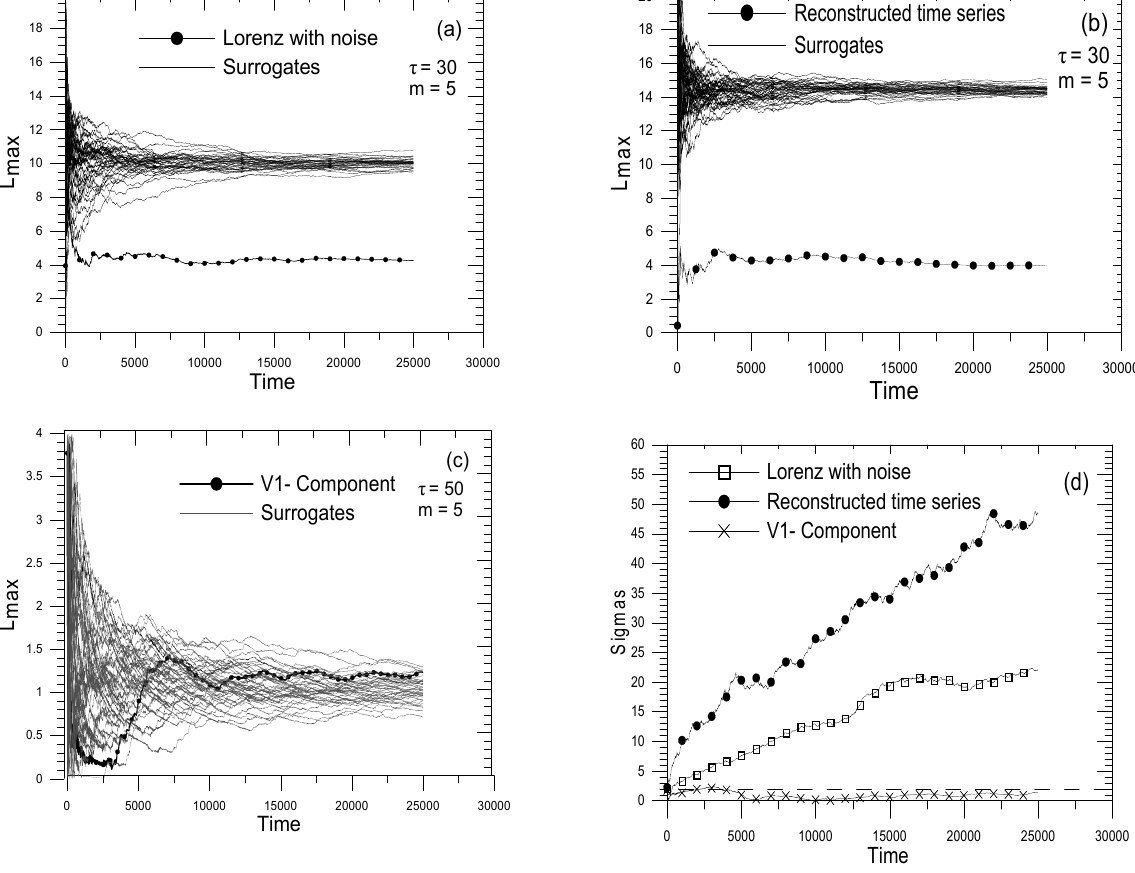
Figure 5 Fig. 5. (a) The largest Lyapunov exponent ( L max ) for the variable x(t) of the stochastic Lorenz dynamical system and its surrogate data as a function of the evolution time estimated for delay time τ = 30 and embedding dimension m = 5. (b, c) The same with (a) but for the reconstructed and the V 1 -component time series of the stochastic Lorenz time series, estimated for embedding dimension m =5 and corresponding delay time τ = 30 , 50. (d) The significance of the discriminating statistic of the largest Lyapunov exponent as a function of the evolution time, for the stochastic Lorenz time series, its reconstructed and its V 1 -component time